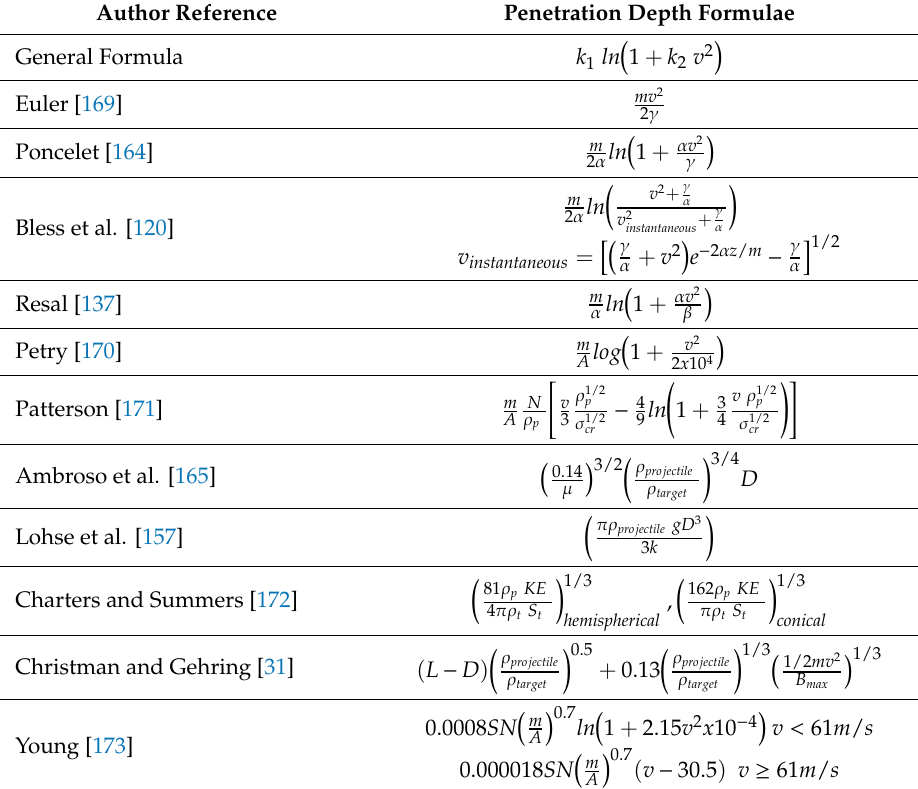
Table A3. Penetration depth Formulae by di ff erent Authors.